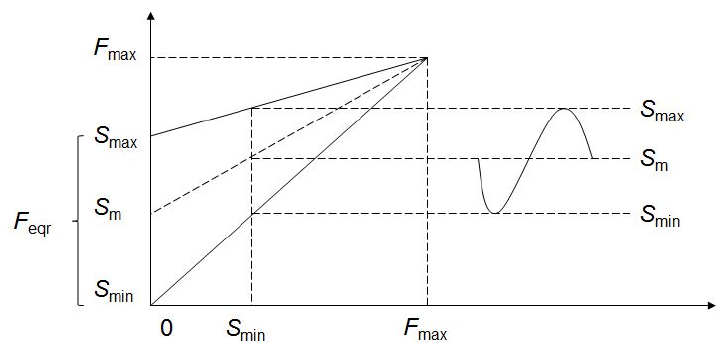
Figure 1. Equivalent load range.